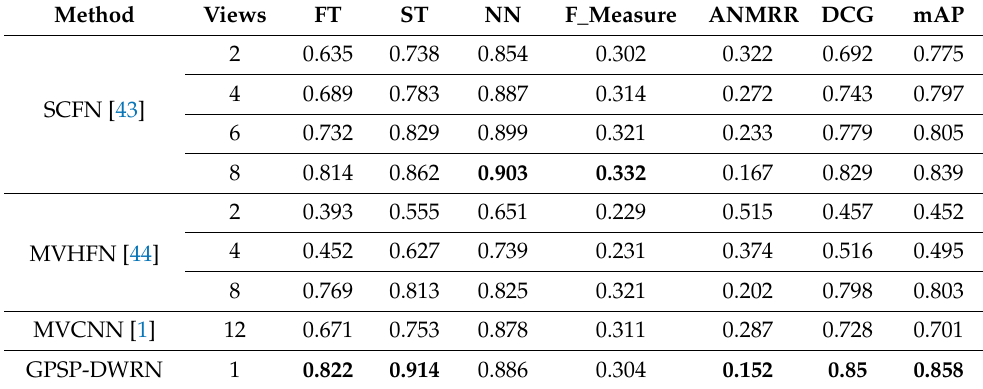
Table 4. Retrieval performance—ModelNet40. Bolding shows the maximum value in each column.